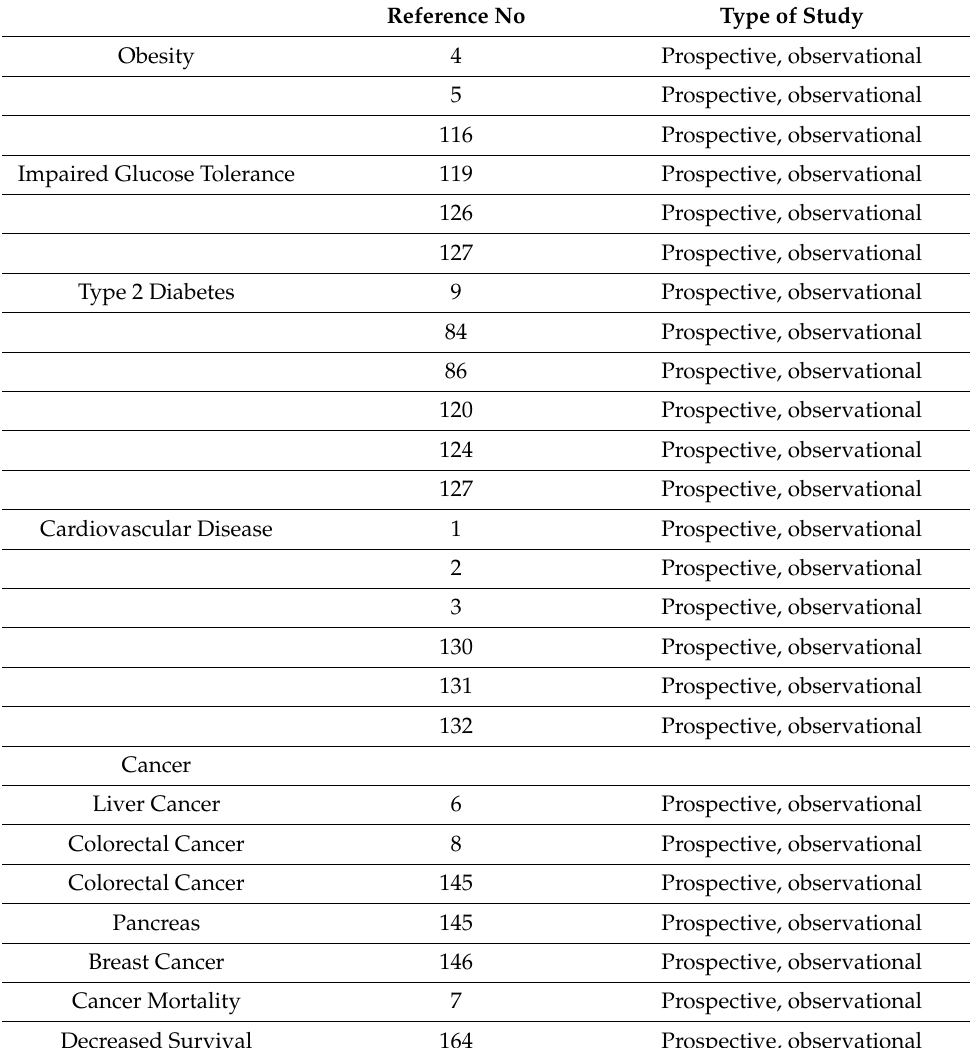
Table 2. Hyperinsulinemia at baseline is positively associated with the development of many conditions and diseases at